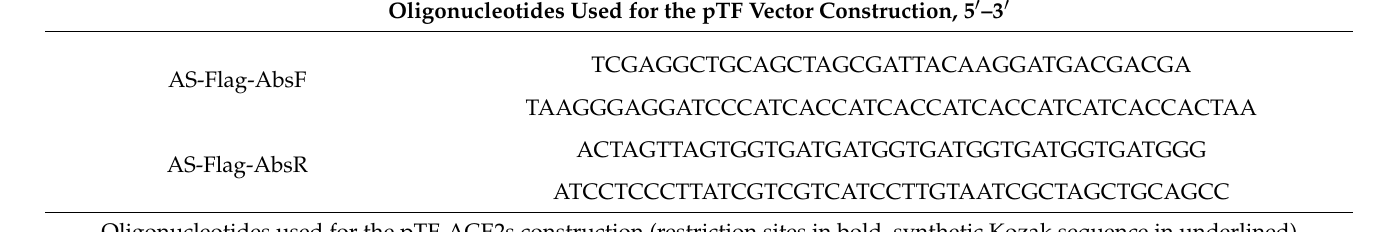
Table A1. Oligonucleotides used for cloning and sequencing.